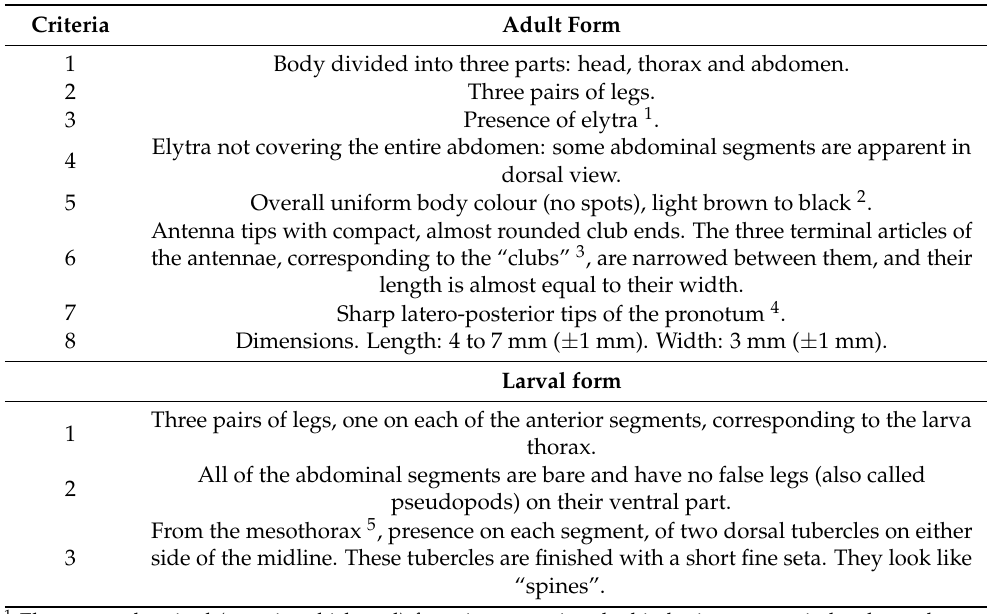
Table 1. Morphological identification of Aethina tumida Murray–Criteria for adult and larva diagnosis [7,23].